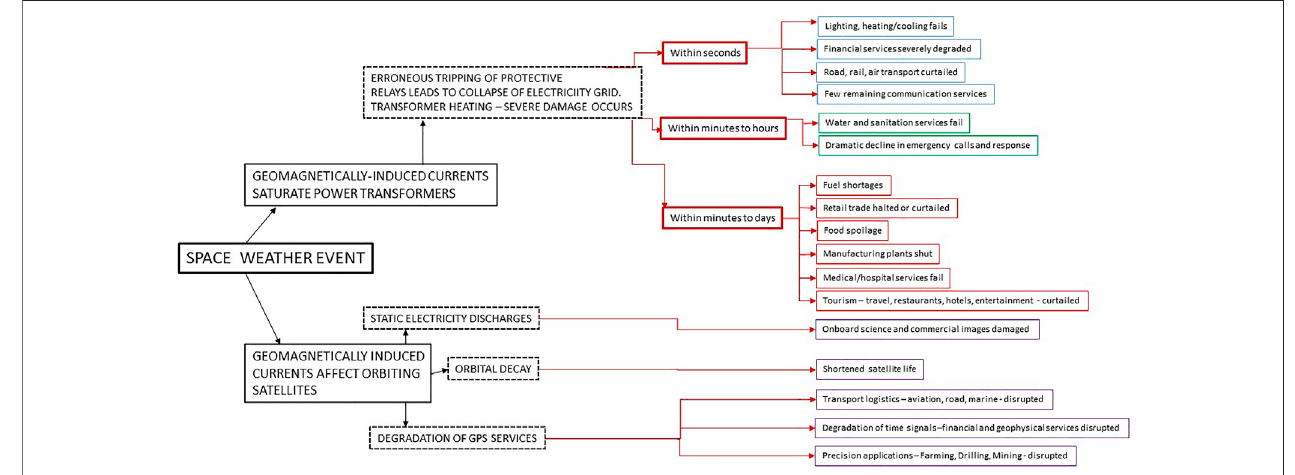
FIGURE 4 | The cascading effects of a geomagnetic